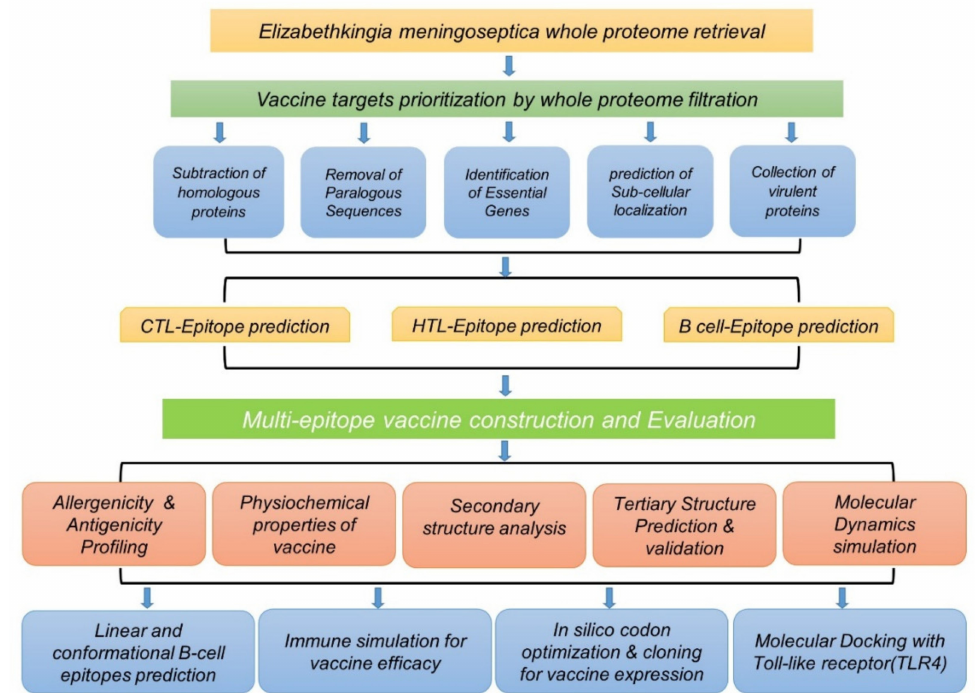
Figure 1. Flow chart of the multi-epitope subunit immunogenic construct against E. meningoseptica, following a reverse vaccinology